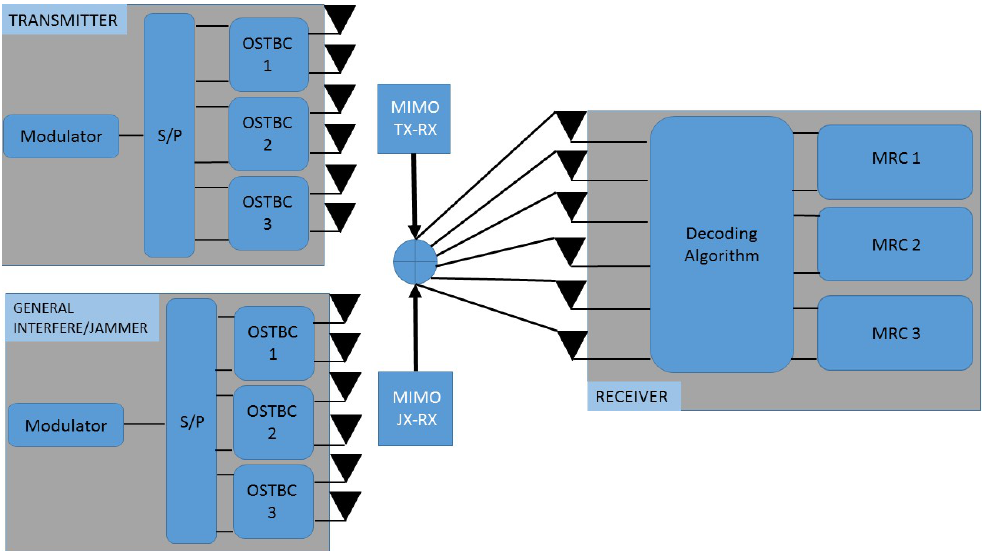
Figure 1. Scheme blocks of the MGSTC transmitter, general receiver (including MGSTC or AP-HSIC decoding algorithm), and general interference/smart